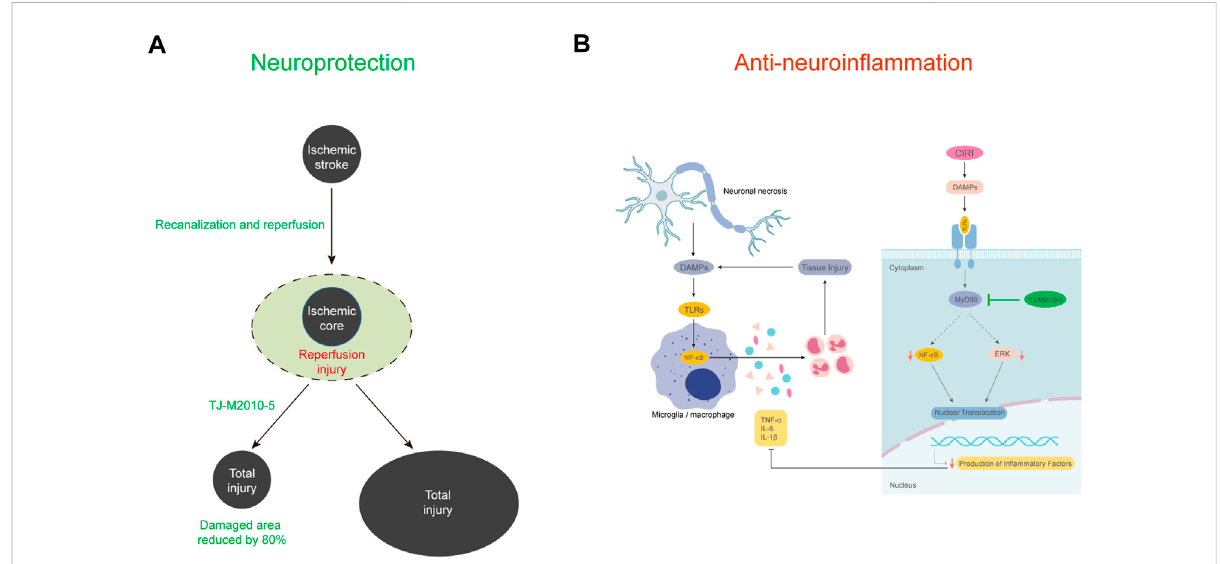
FIGURE 8 Schematic model of the present study. (A) The occurrence of reperfusion injury after vascular recanalization in ischemic stroke signi fi cantly expands the fi nal necrotic area. TJ-5 reduces the fi nal necrotic area by reversing ischemia-reperfusion injury. (B) The activation of microglia and in fi ltration of myeloid cells promote neuroin fl ammation and brain tissue injury after acute cerebral I/R. TJ-5 obstructs the vicious circle of neuroin fl ammatory injury by inhibiting MyD88/NF- κ B and ERK signaling